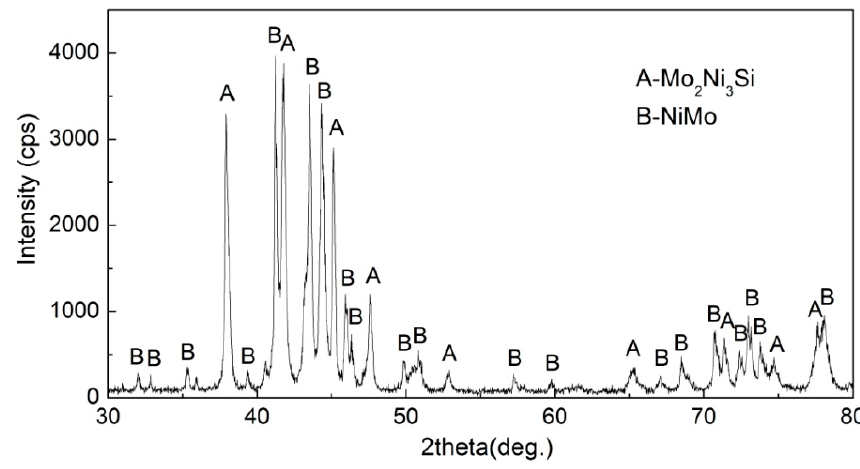
Figure 3. X-ray diffraction (XRD) profiles of the Ni–Mo–Si intermetallic composite.